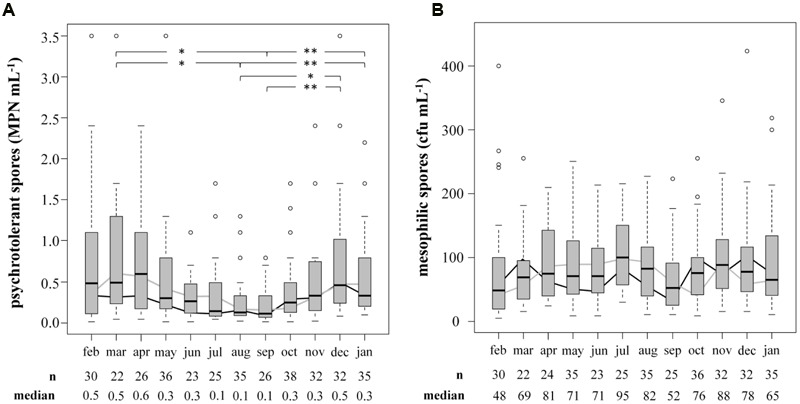
Influence of the season on counts of psychrotolerant (A) and mesophilic (B) spores in bulk tank milk. Two consecutive years from February 2014 to January 2016 were analyzed. Boxplots display the combined values of both years. The boxes represent first quartile, median, and third quartile, the whiskers represent mild outliers (1.5 x interquartile range), and open circles represent more extreme outliers. Y axes are discontinued at 3.5 MPN mL-1 for psychrotolerant spores and at 400 cfu mL-1 for mesophilic spores. The following outliers are not displayed. Psychotolerant spores: Feb: 9.2; Apr: 5.4; May: 5.4, >16.0; Oct: >16.0; Nov: 9.2; Mesophilic spores: Jan: 468; Aug: 4,073; Oct: 2,300; Dec: 896. black line: geometric mean in year one; gray line: geometric mean in year two.∗p < 0.05; ∗∗p < 0.01.